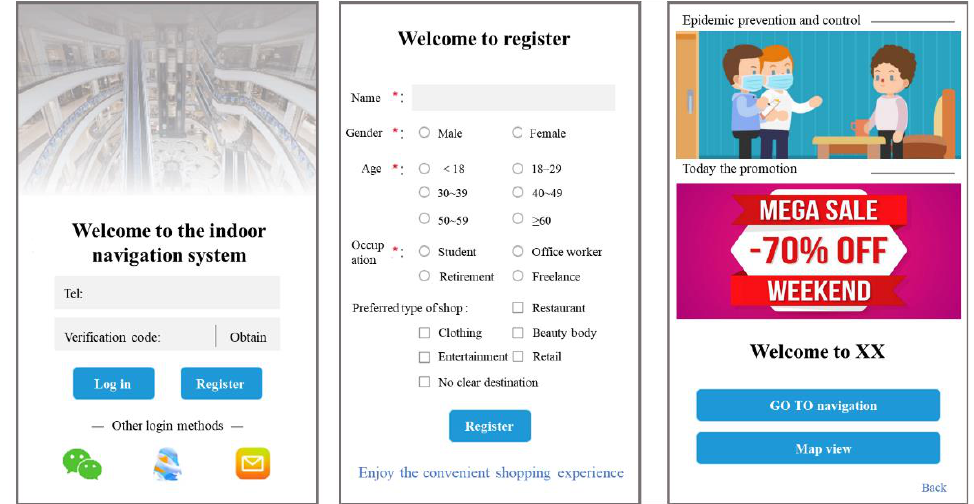
Figure 19. Shopping mall indoor navigation system login page.